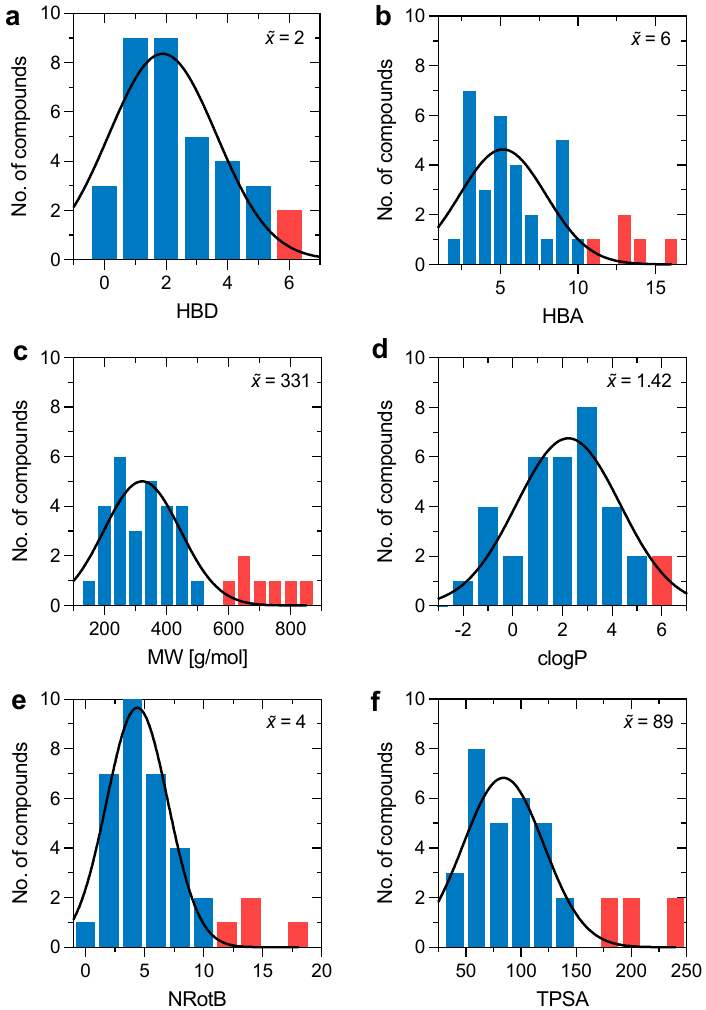
Figure 2. Distribution of the ( a ) hydrogen bond donors (HBD), ( b ) hydrogen bond acceptors (HBA), ( c ) molecular weight (MW), ( d ) calculated partition coefficient (clogP), ( e ) rotatable bonds (NRotB), and ( f ) topological polar surface area (TPSA) for the investigated dataset. Values that adhere to the Lipinski rule of five and Veber’s rule are colored in blue. The inset number represents the median of the dataset for each molecular descriptor.